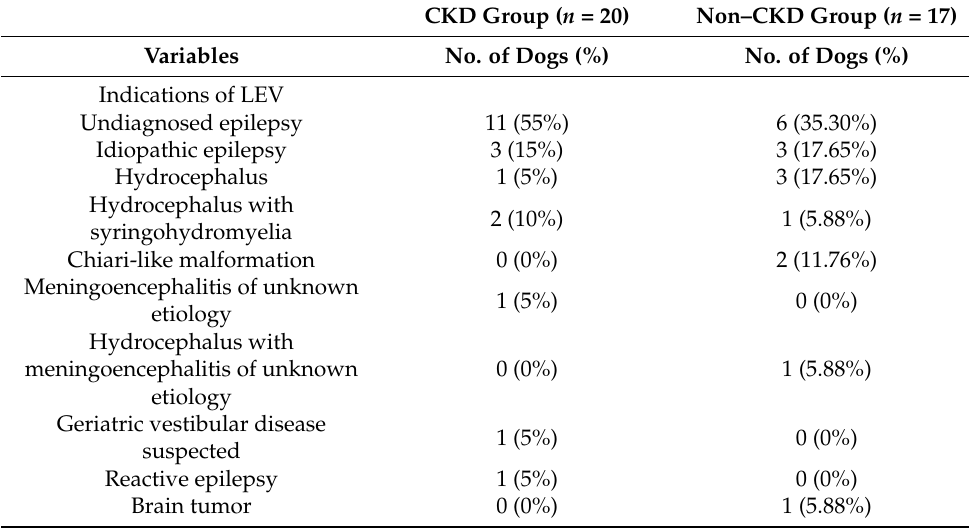
Table 2. LEV-based therapy in dogs of the CKD group/non-CKD